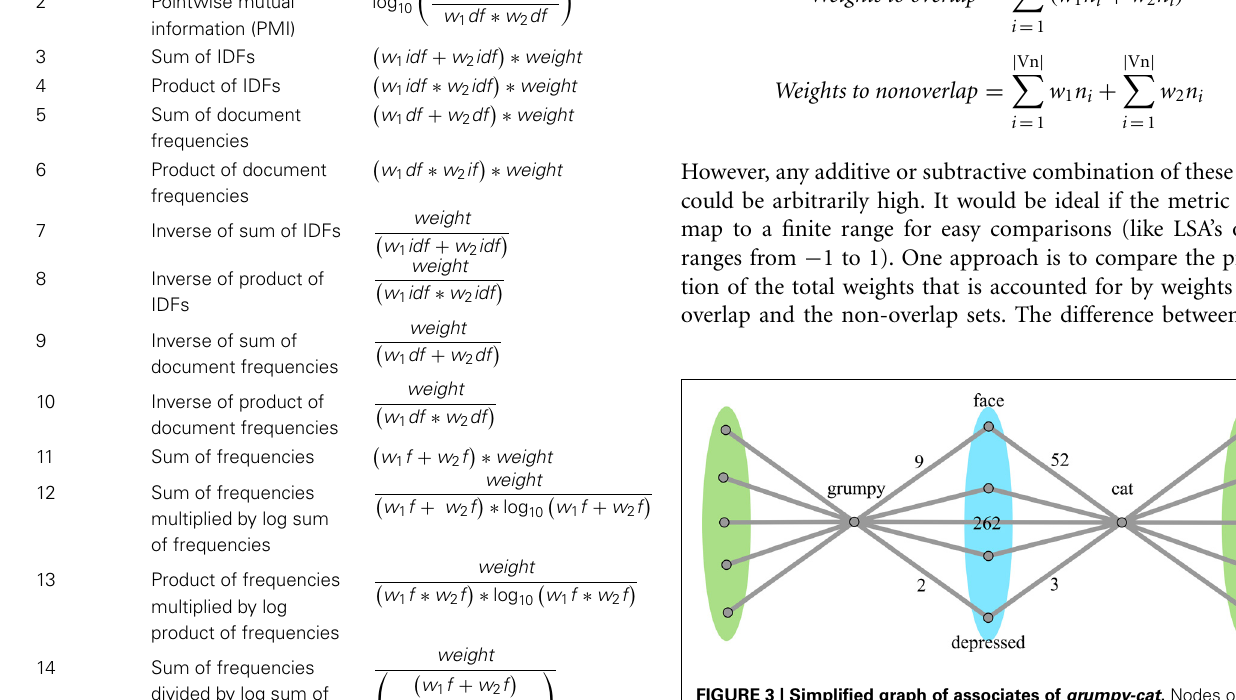
FIGURE 3 | Simplified graph of associates of grumpy-cat . Nodes on the blue region are the overlapping nodes, each of which is connected to both words in the word pair. Nodes on the green regions are the non-overlapping nodes, each of which is connected to only one of the words in the word pair. For clarity, only a few nodes are